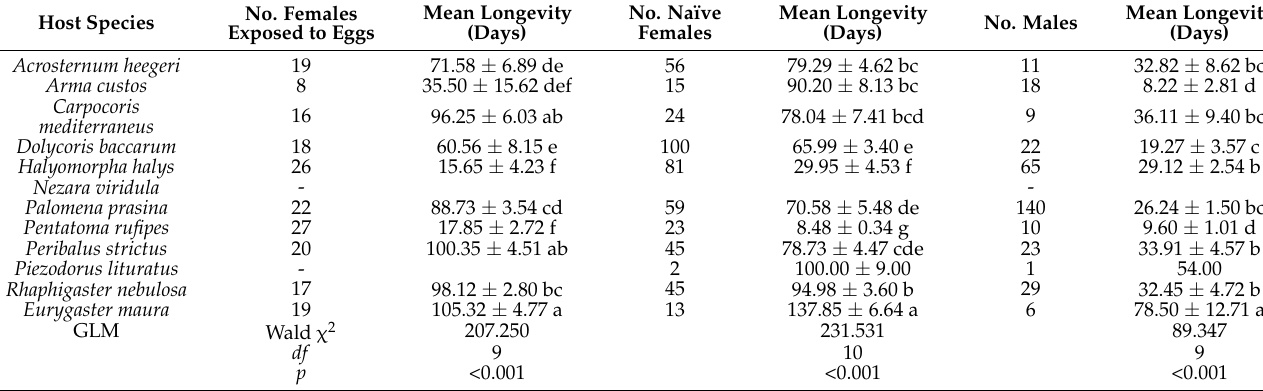
Table 4. Mean longevity of Trissolcus kozlovi females previously exposed to egg mass, naive females, and males, reared from 12 Pentatomidae and Scutelleridae species. In each column, values followed by the same letter are not significantly different (stratified log-rank